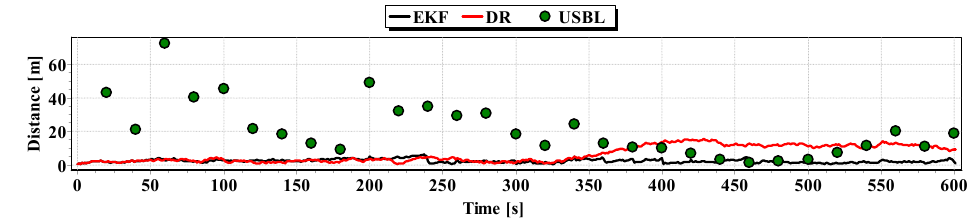
Figure 23. Graph of the reference position distance from the position estimated by EKF and DR methods and determined by the USBL system (single passage).